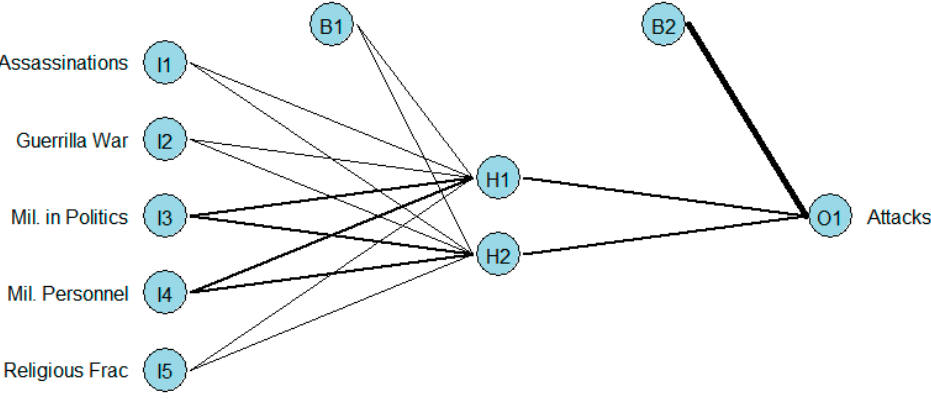
Figure 1. ANN Diagram